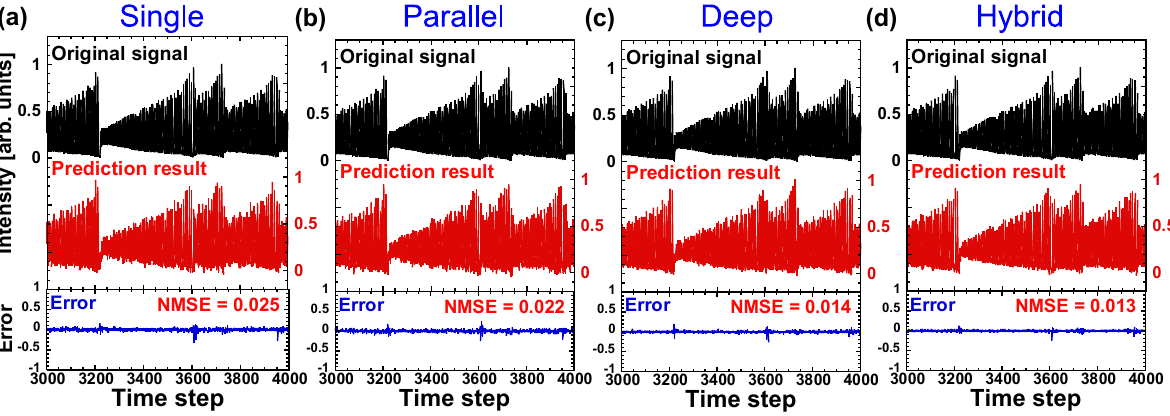
Figure 3: Results of the chaotic time-series prediction task using (a) single, (b) parallel, (c) deep, and (d) hybrid configurations. The original target signal (black), prediction result (red), and error between them (blue) are shown.